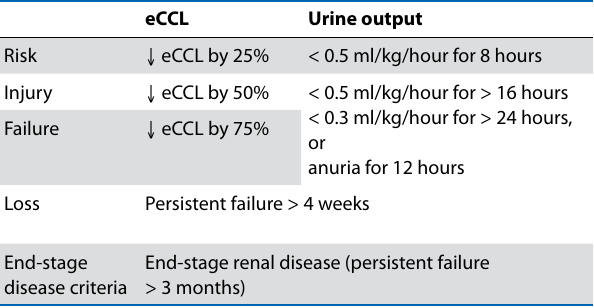
Table 2: Paediatric modified risk, injury, failure, loss and end-stage rental disease criteria 16 eCCL Urine